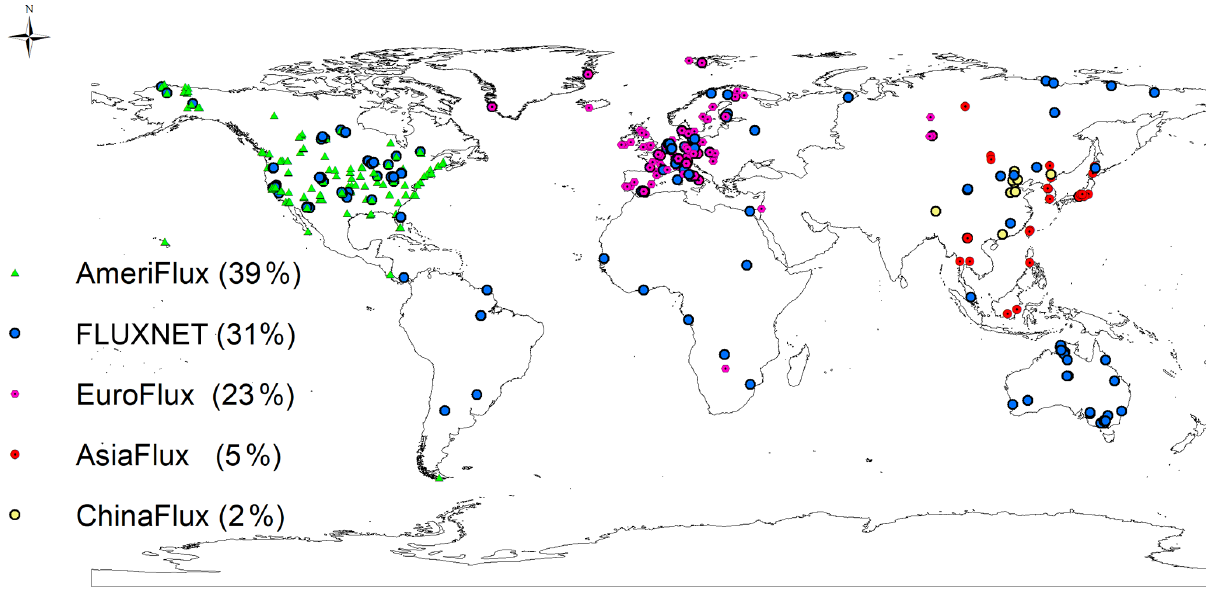
Figure 1. Spatial distribution of 645 in situ flux EC sites across the